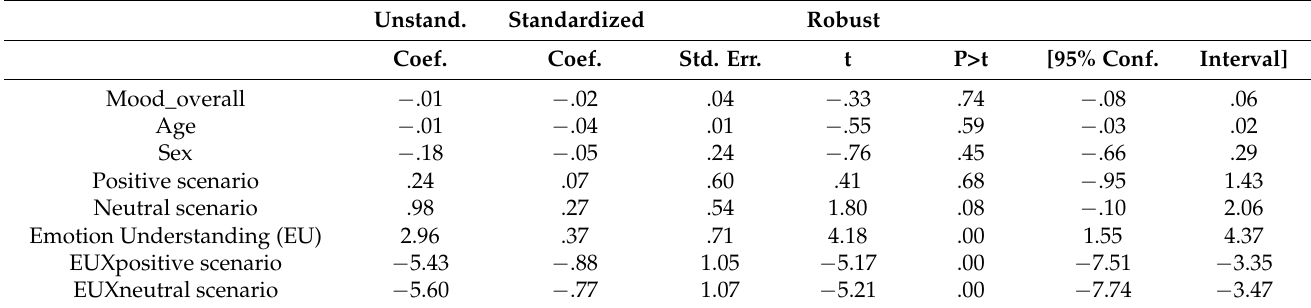
Table 2. Regression results of scenario content, emotion understanding, and control variables on impression formation.